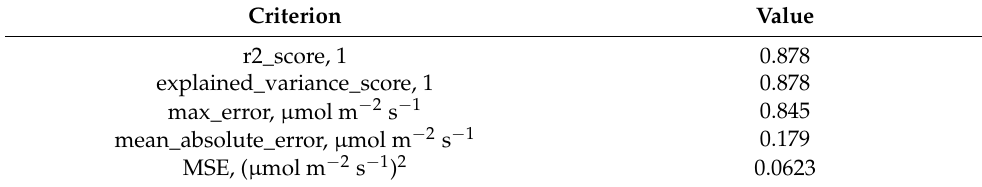
Table 4. The results of experiment 4.